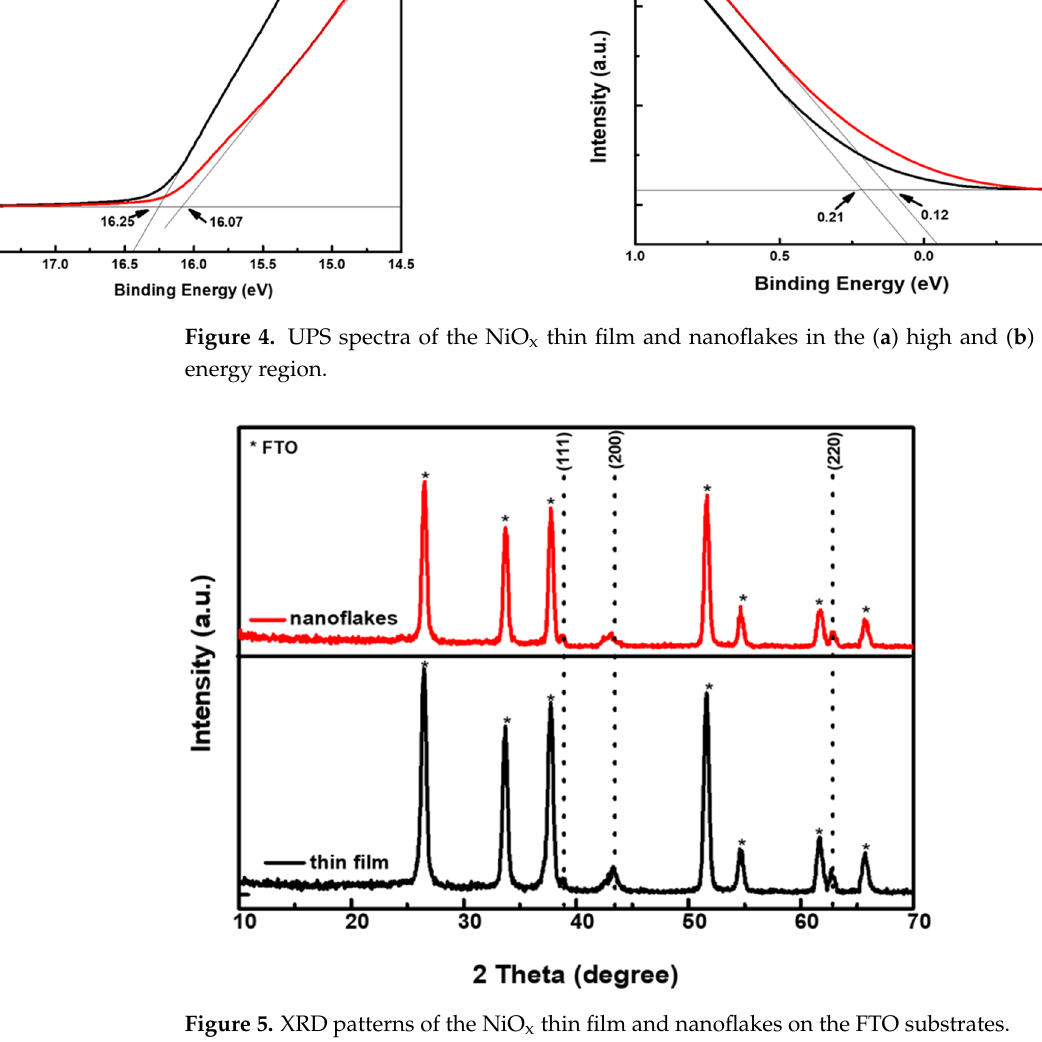
Figure 6. XPS spectra of Ni 2p 3/2 and O 1s elements in the ( a , c ) NiO x thin film and ( b , d ) nanoflakes. 3.2. Characterization of Perovskite Layers on NiO x Figure 7a,b show the cross-sectional SEM micrographs of the whole devices using the NiO x thin film and nanoflakes as the HTL, respectively. The perovskite layer has a thickness of 550 nm on both NiO x . Moreover, the perovskite nanocrystals with larger grain sizes and fewer grain boundaries were obtained on the NiO x nanoflakes, meaning that fewer defects were produced as compared with the NiO x thin film. Figure 7c,d re- veal the top-view SEM micrographs of the perovskite on the NiO x film/PTAA and NiO x nanoflakes/PTAA, respectively. It is noted that a thin PTAA layer was inserted between NiO x and the perovskite layer for the two samples. The grain size of the perovskite de-